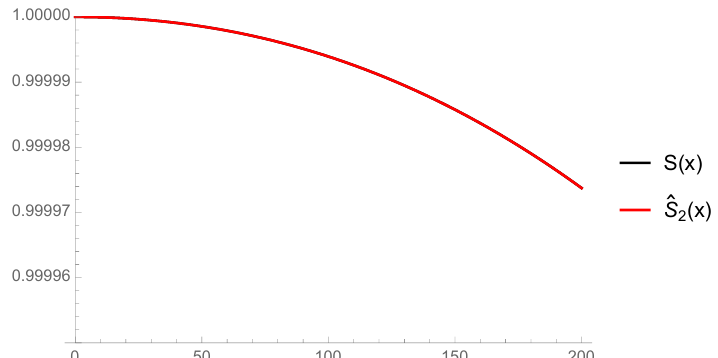
Figure 4. Survival function, S ( x ) , and the second approximation, ˆ S 2 ( x ) , for k = 5 and p = 7 of the concatenated Markov process for real bladder cancer